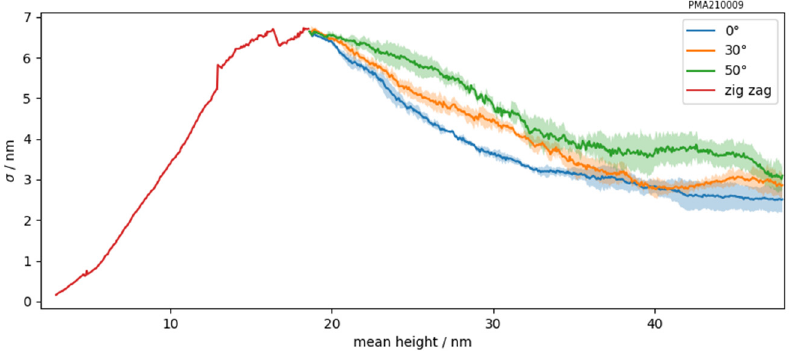
Figure 11. Standard deviation σ of the height during growth of the first layer (zig zag) and the continued growth of the second layer with different coating conditions on the right including also the fluctuation (standard deviation) as shaded region.